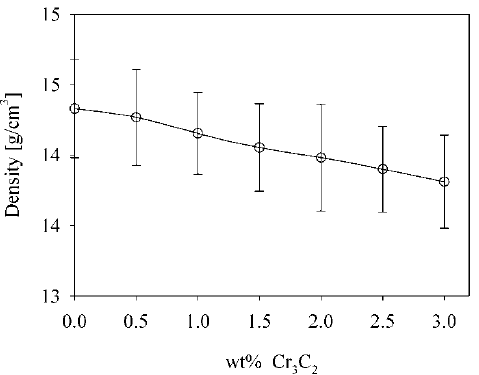
Figure 4. Effect of the Cr 3 C 2 addition on the density of the WC-10Co cemented carbide.